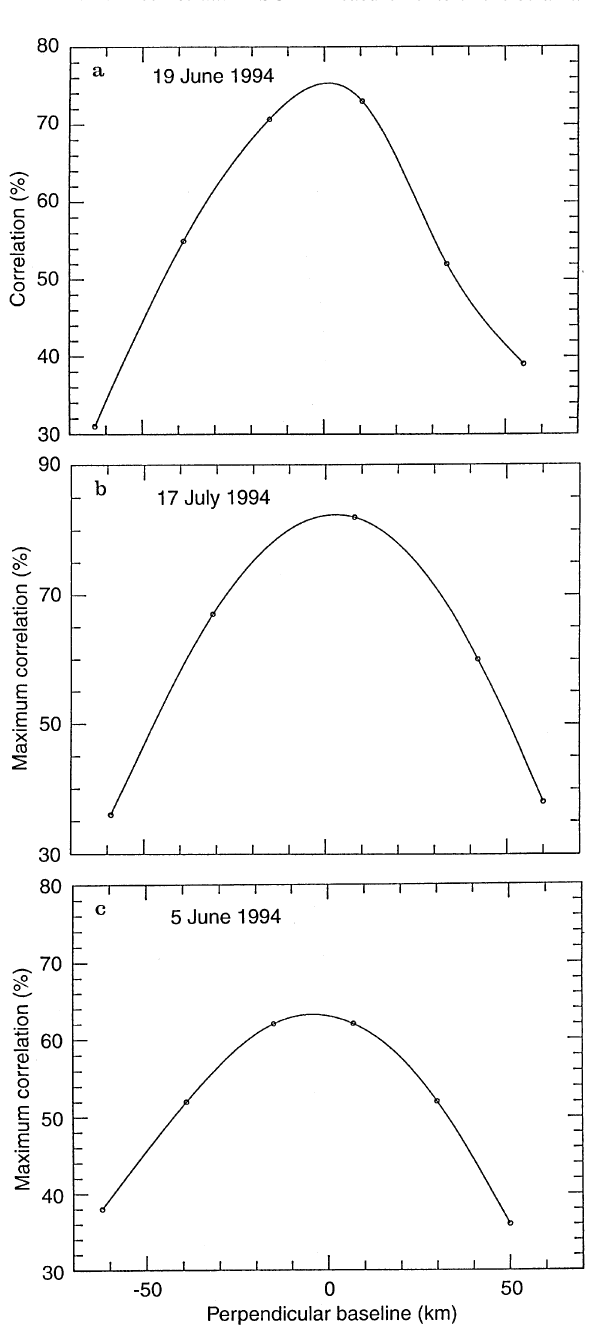
Fig. 8. a Maximum cross-correlation versus perpendicular baseline for observations of 0625 # 146 on 19 June 1994. When the velocity of the Earth is taken into account the maximum cross-correlation between the measurements occurs when the perpendicular baseline is zero, indicating that the solar wind velocity is purely radial. b As a but showing observations of 0745 # 101 on 17 July 1994; c max- imum cross-correlation versus perpendicular baseline for observa- tions of 0521 # 166 on 5 June 1994. The maximum cross-correlation occurs for a small negative perpendicular baseline, suggesting that the solar wind velocity may be 1.0 ° to 1.5 ° offradial June 1995. The map is plotted in a ‘natural’ grey-scale, with the bright equatorial region appearing in white and the large polar coronal holes as dark areas. Contour lines of constant brightness are added as a guide. The solid